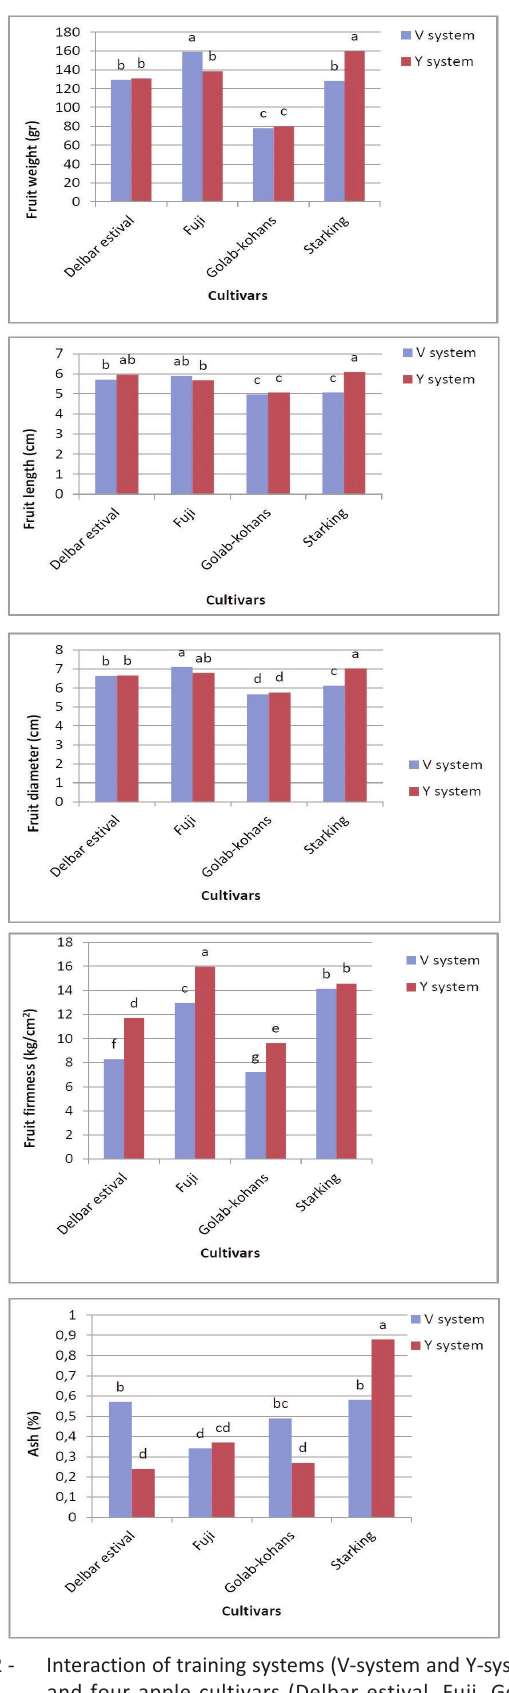
Fig. 2 - Interaction of training systems (V-system and Y-system) and four apple cultivars (Delbar estival, Fuji, Golab- kohans and Starking) on fruit